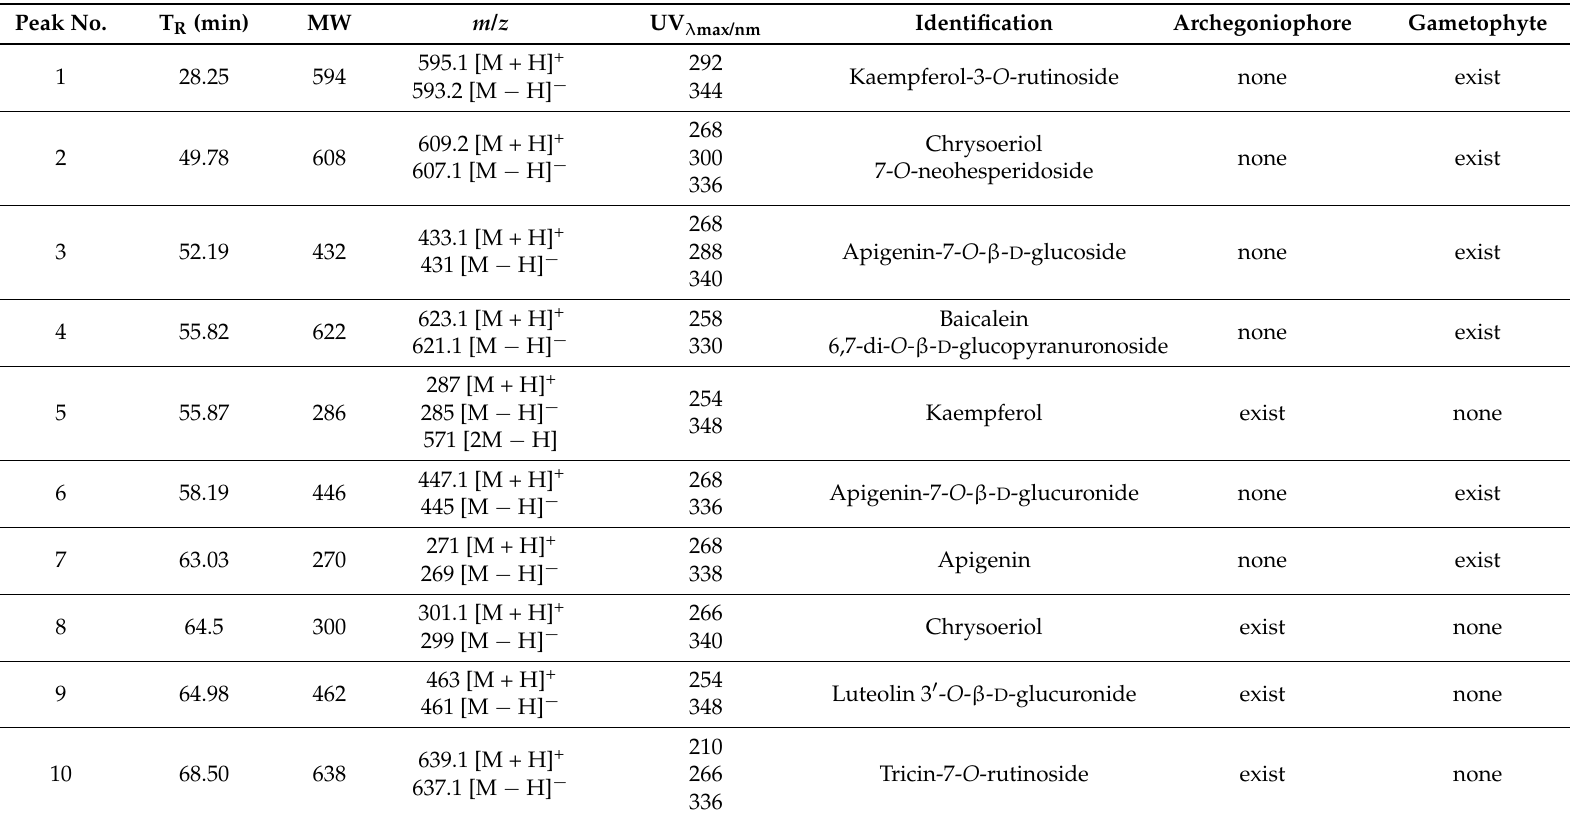
Table 1. Flavonoids identified tentatively in the archegoniophore and the gametophyte of M. polymorpha L . Peak